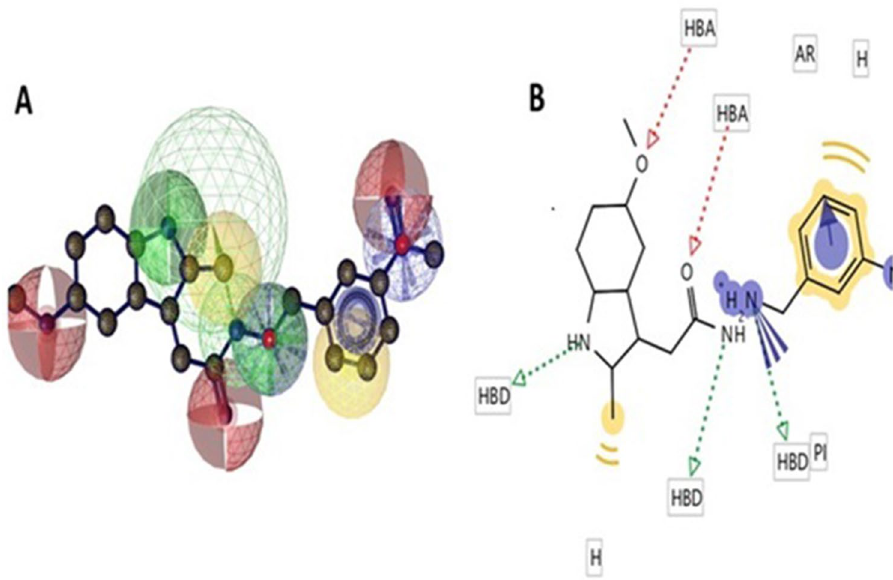
Figure 12. Pharmacophore model of DMFM compound. ( A ) 3D representation of DMFM pharmacophore model. Red spheres represent hydrogen bond acceptor (HBA), green spheres represent hydrogen bond donor (HBD), and yellow spheres depict aromatic rings. ( B ) The same color theme with the same descriptors is represented in 2D